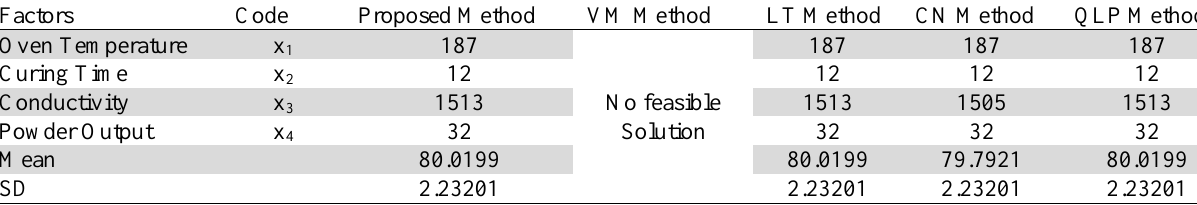
Comparison of results obtained using different optimization methods